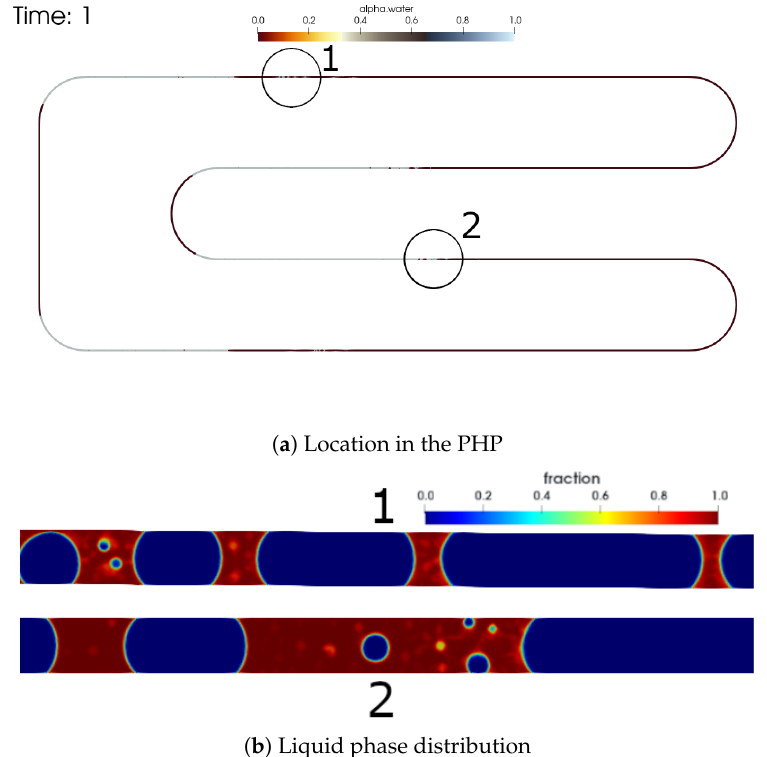
Figure 17. Numerical results of the Lee model [27] in 1.0 s for 100 W input power.